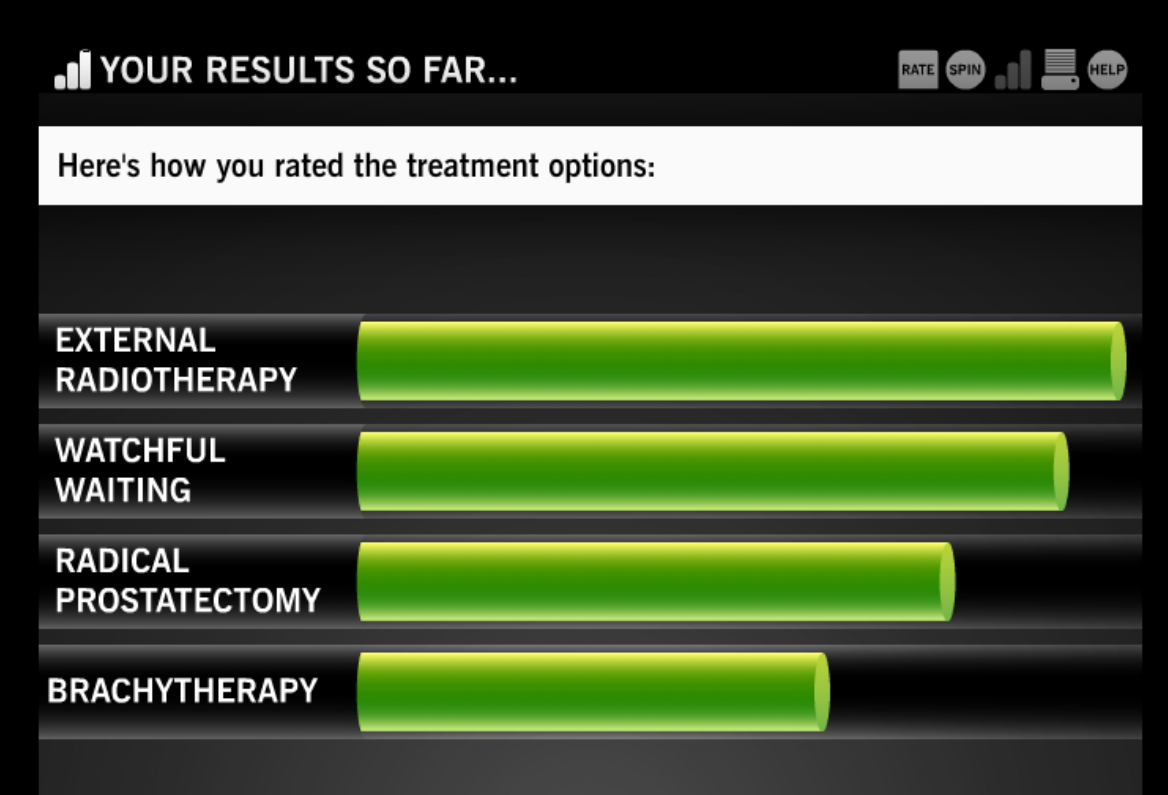
Figure 5. The first-round results screen, which includes a ranked comparison of all treatments (users are encouraged to complete more rounds to refine their